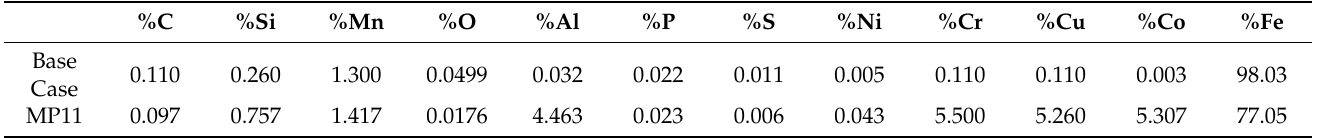
Table 1. Bulk chemical composition of weld metals (mass%).